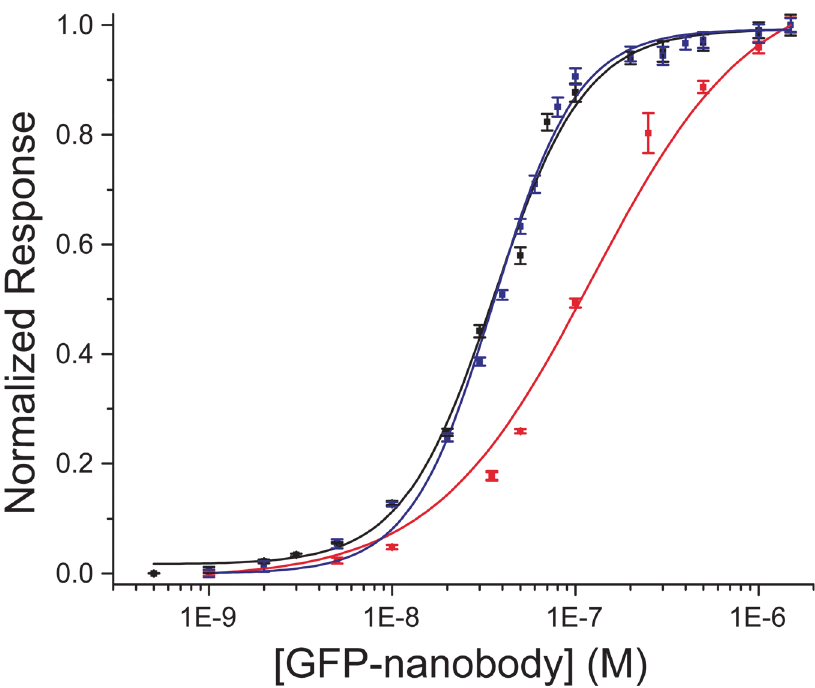
Fig 2. Endpoint response of the reference subtracted binding curves describing the interaction between the GFP-Nb and the different surfaces as function of GFP-Nb concentration. The red, blue and black squares are the raw data for the Ni:NTA, the anti-polyhistidine and the CAP chip respectively, and the lines are the best fit of the data set to the Hill ’ s equation (R 2 = 0.99). As choosing a Hill ’ s coefficient equal to 1 did not produce a good fit of the data describing the interaction between the GFP-Nb and the anti- polyhistidine and the CAP-chip (S2 Fig), a Hill ’ s coefficient of 2 was set for these lines.